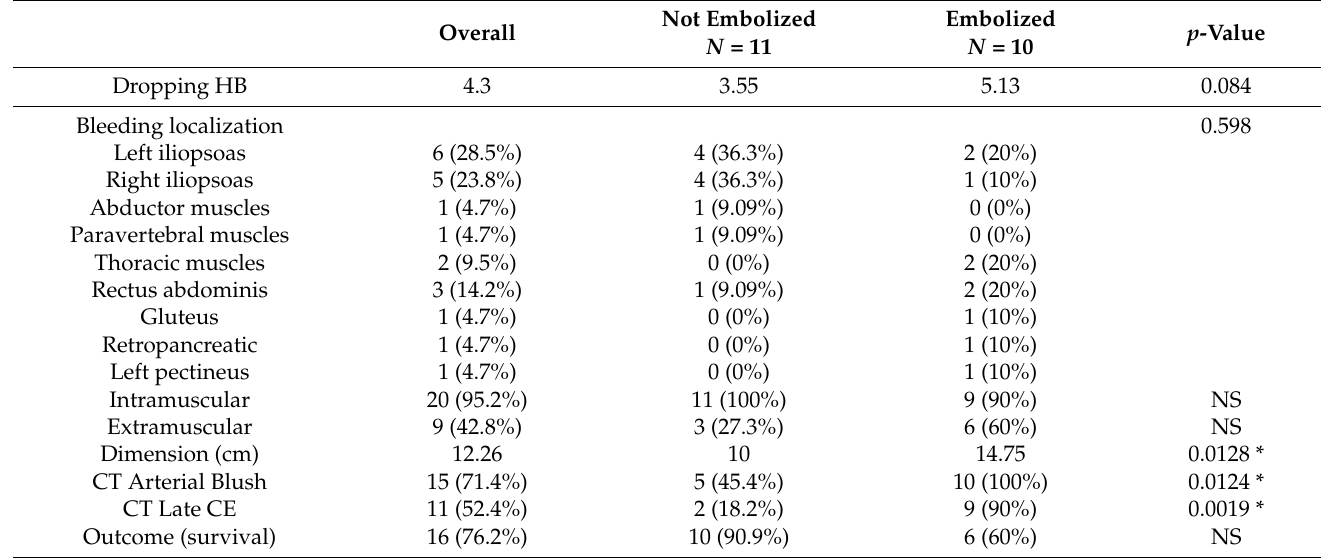
Table 2. Major radiological features and severity criteria within embolized and not-embolized patients.